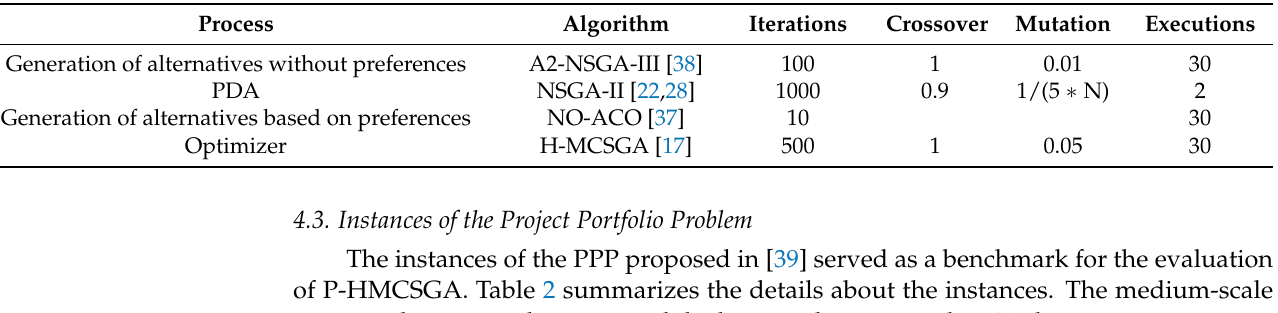
Table 1. Algorithms used in the proposed P-HMCSGA.